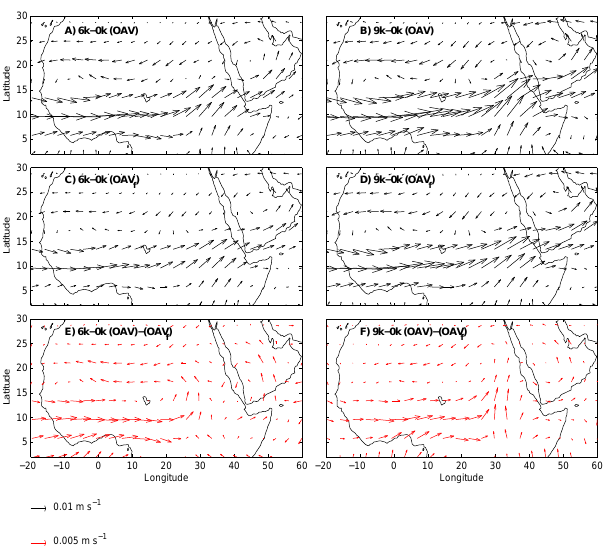
Figure 5. As in Fig. 3 but for changes in summer moisture transport at